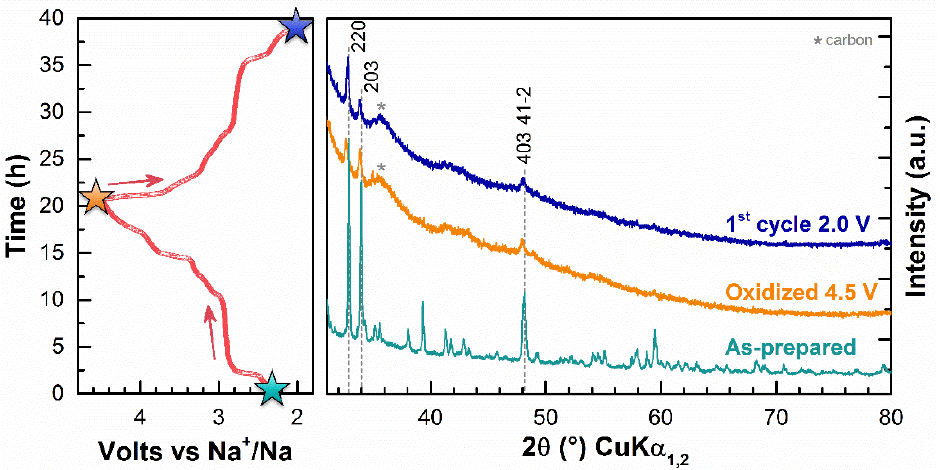
Figure 5. Powder X-ray diffraction patterns of the as-prepared phase and the oxidized phase at 4.5 V after one cycle between 4.5 and 2.0 V, respectively, in cyan, orange, and blue. The galvanostatic profile at C/20 is also given with the three colored stars corresponding to these three phases.